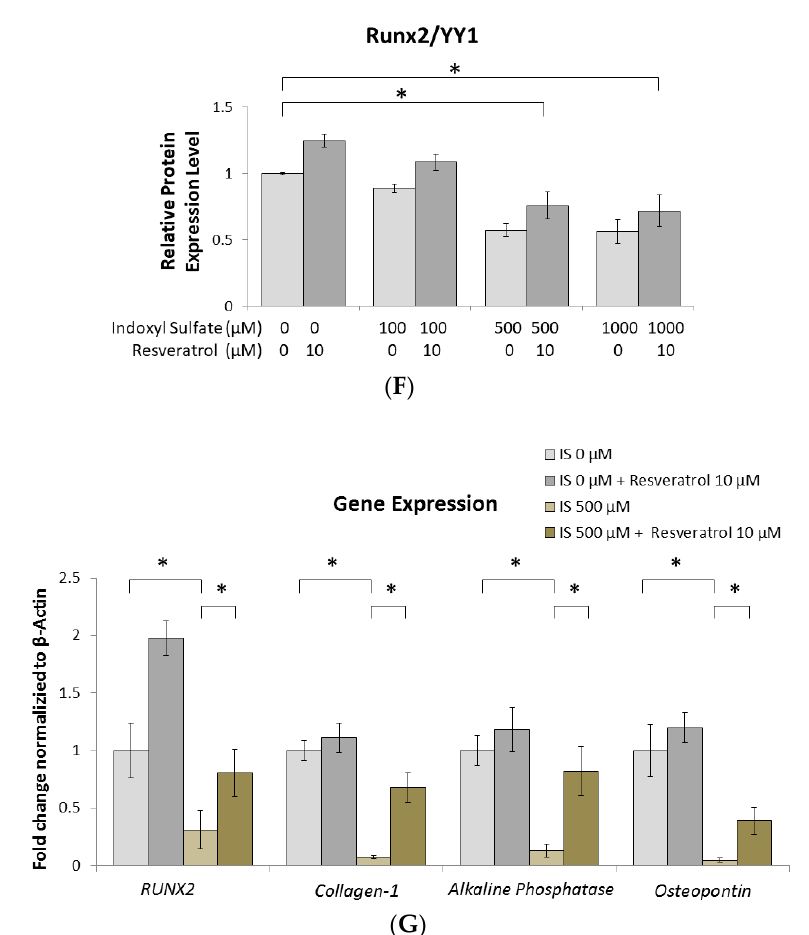
Figure 3. The effect of RSV on IS-induced actuate aryl hydrocarbon receptor (AhR) signaling and the rescue of osteoblast differentiation. MC3T3 E1 cells were cultured in an osteogenesis medium with IS at 0, 100, 500, and 1000 μ M both with and without RSV for 2 days. ( A – C ) In whole cells, the protein expression of CYP1B1 significantly increased in response to 500 μ M IS compared to the control group. At 1000 μ M IS, the protein expression of both CYP1A1 and CYP1B1 significantly increased compared to the control group. Moreover, RSV significantly suppressed CYP1A1 and CYP1B1 expression. ( D ) At 500 μ M IS, the expression of AHR, CYP1A1, and CYP1B1 genes was significantly increased compared to their levels in the control group. In addition, when adding 10 μ M RSV to the cells already treated with 500 μ M IS, the expression of AhR and CYP1B1 was significantly suppressed. ( E , F ) In the nucleus, the protein expression of Runx2 was significantly decreased at 500 and 1000 μ M IS. ( G ) At 500 μ M IS, the expression of RUNX2, collagen 1, alkaline phosphatase, and osteopontin genes were all significantly lower compared to their expression in the control group. Data are represented as the mean ± SEM ( n = 3). * Indicates differences that were considered significant between the indicated groups ( p < 0.05).